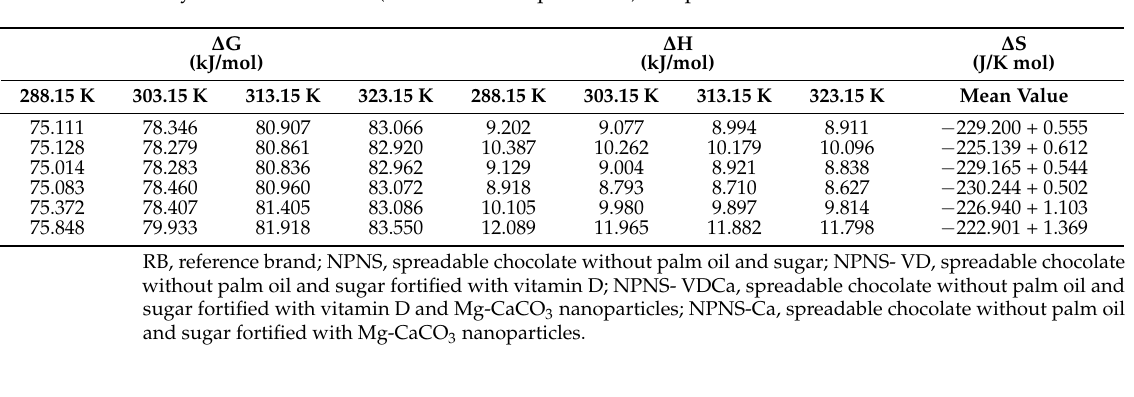
Table 5. ∆ G, ∆ H, and ∆ S of chocolate spread formulations. ∆ G and ∆ H are expressed as kJ/mol. Only mean value of ∆ S (at different temperatures) is